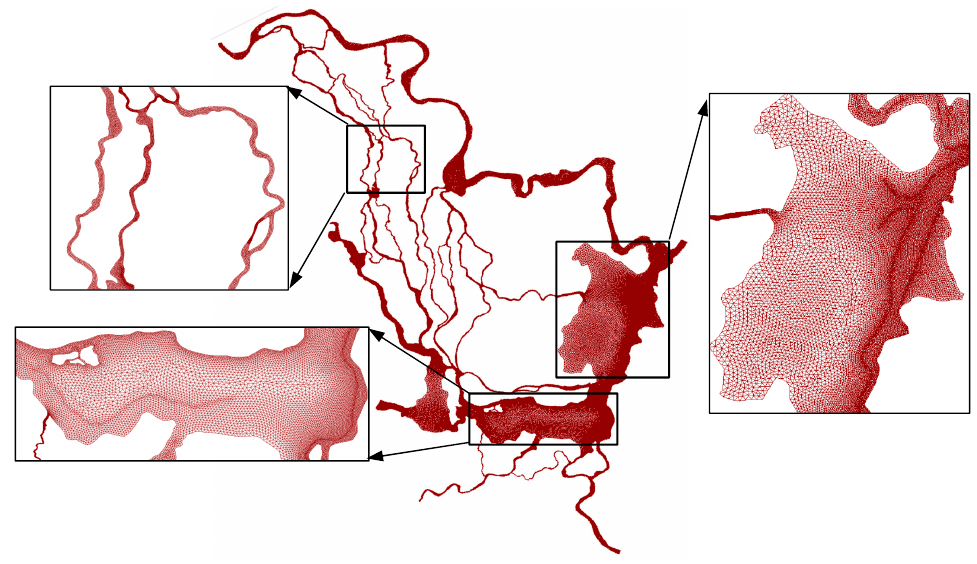
Figure 3. The unstructured grid for the Mike 21 model.